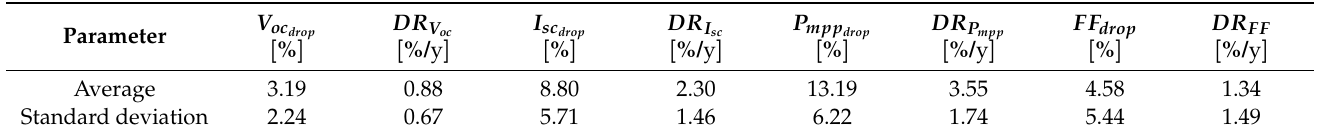
Table 1. Average and standard deviation of absolute degradation (in %) and absolute degradation rate (in %/year) of V oc , I sc , P mpp and FF . Using the average ( x ) and standard deviation values ( σ ), the interval for x is [ x − σ , x + σ ].